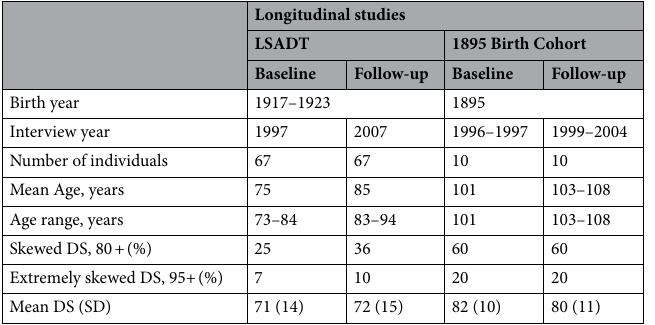
Table 1. Degree of skewness (DS) of X-inactivation in two longitudinal studies; the septuagenarian twin cohort study (LSADT) and the centenarian study (1895 birth